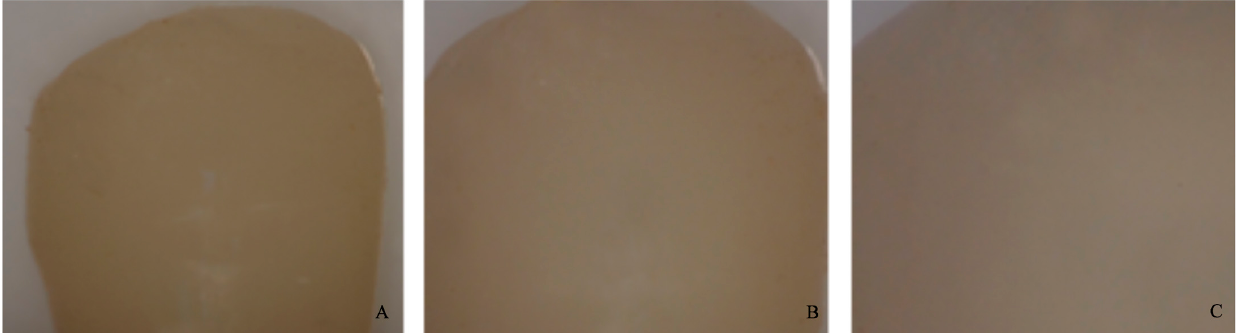
Figure 4. Score 0. ( A ) Magnification: 10 × 1; ( B ) Magnification: 10 × 1.6; ( C ) Magnification: 10 × 2.5. Figure 3. The Universal Testing Machine YLE (GmbH Waldstraße 1/1a, YLE GmbH Waldstrasse 1, D ‐ 64732 Bad Koenig, Germany).